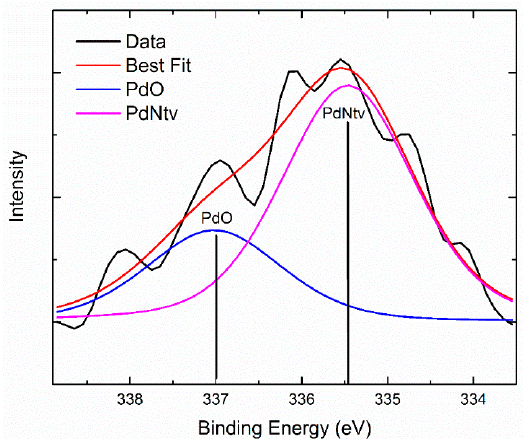
Figure 12. XPS (deconvoluted 3d 5/2 peak) of the catalyst after five catalytic cycles. Many researchers reported deactivation of catalysts by steam at higher temperatures (above 400 °C) resulting in sintering and or poisoning [6,15,16]. At temperatures above 325 °C, the conversion decreased, but the surface Pd content did not change (Table 4). The catalyst after reaction with 2%